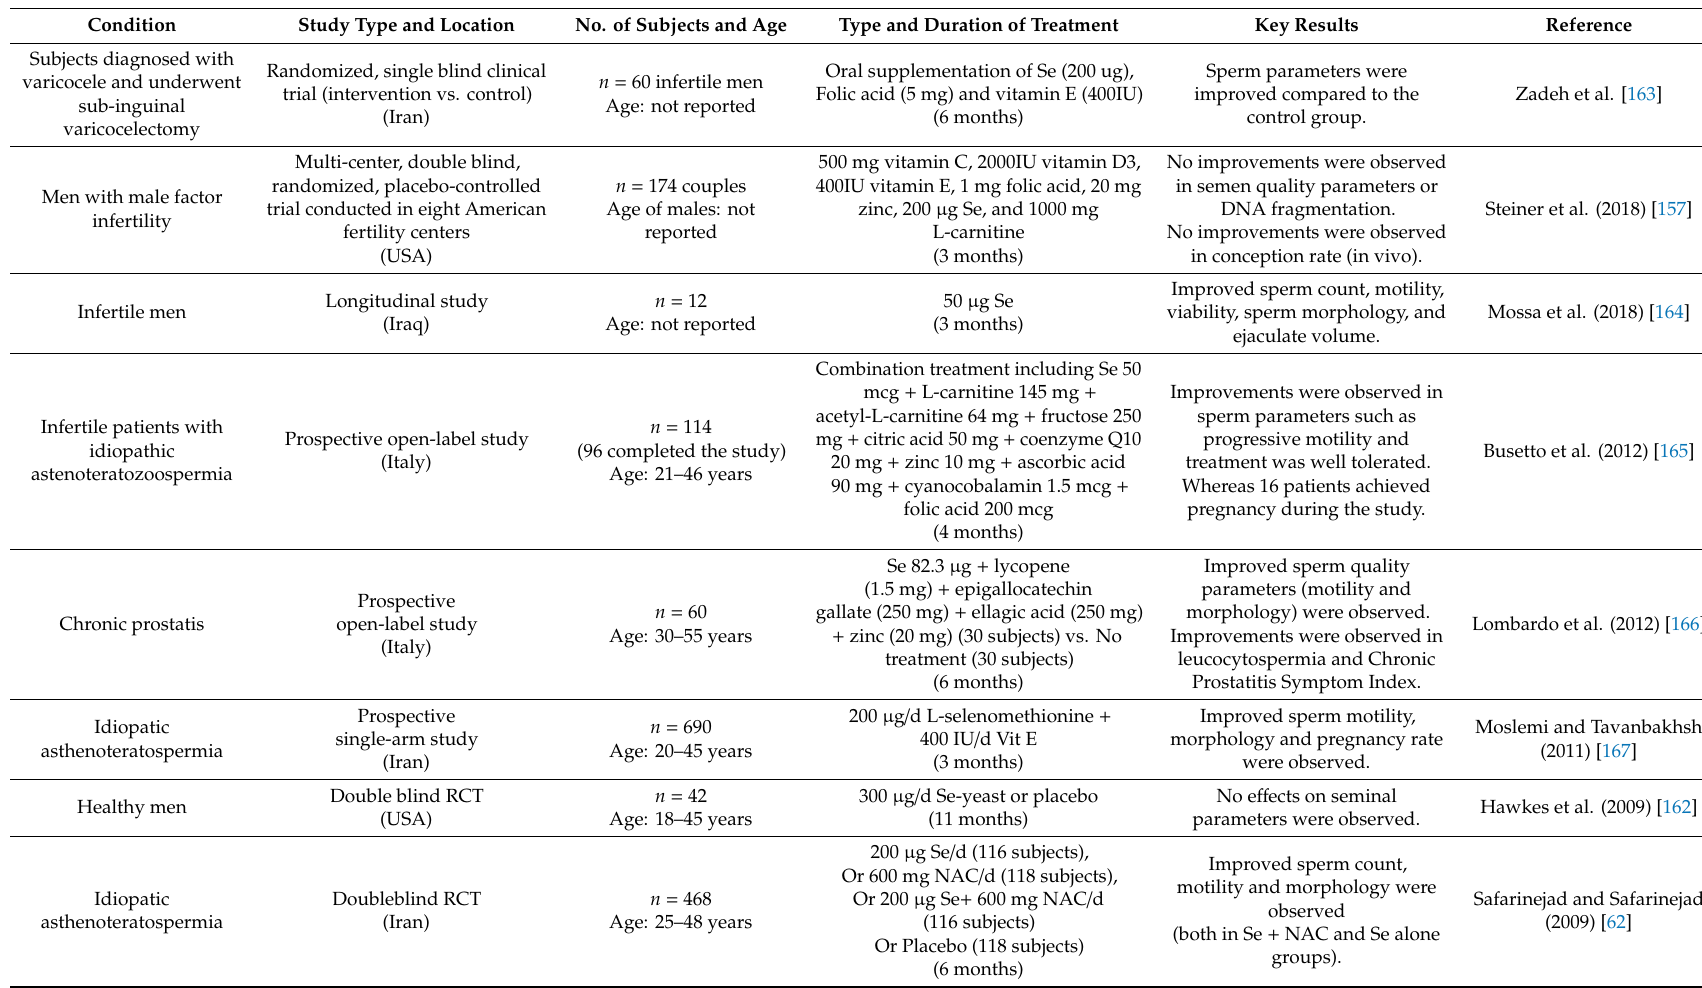
Table 7. Human studies (2009–2019) involving selenium supplementation to improve male fertility / reproductive status / clinical outcomes. Condition Study Type and Location No. of Subjects and Age Key